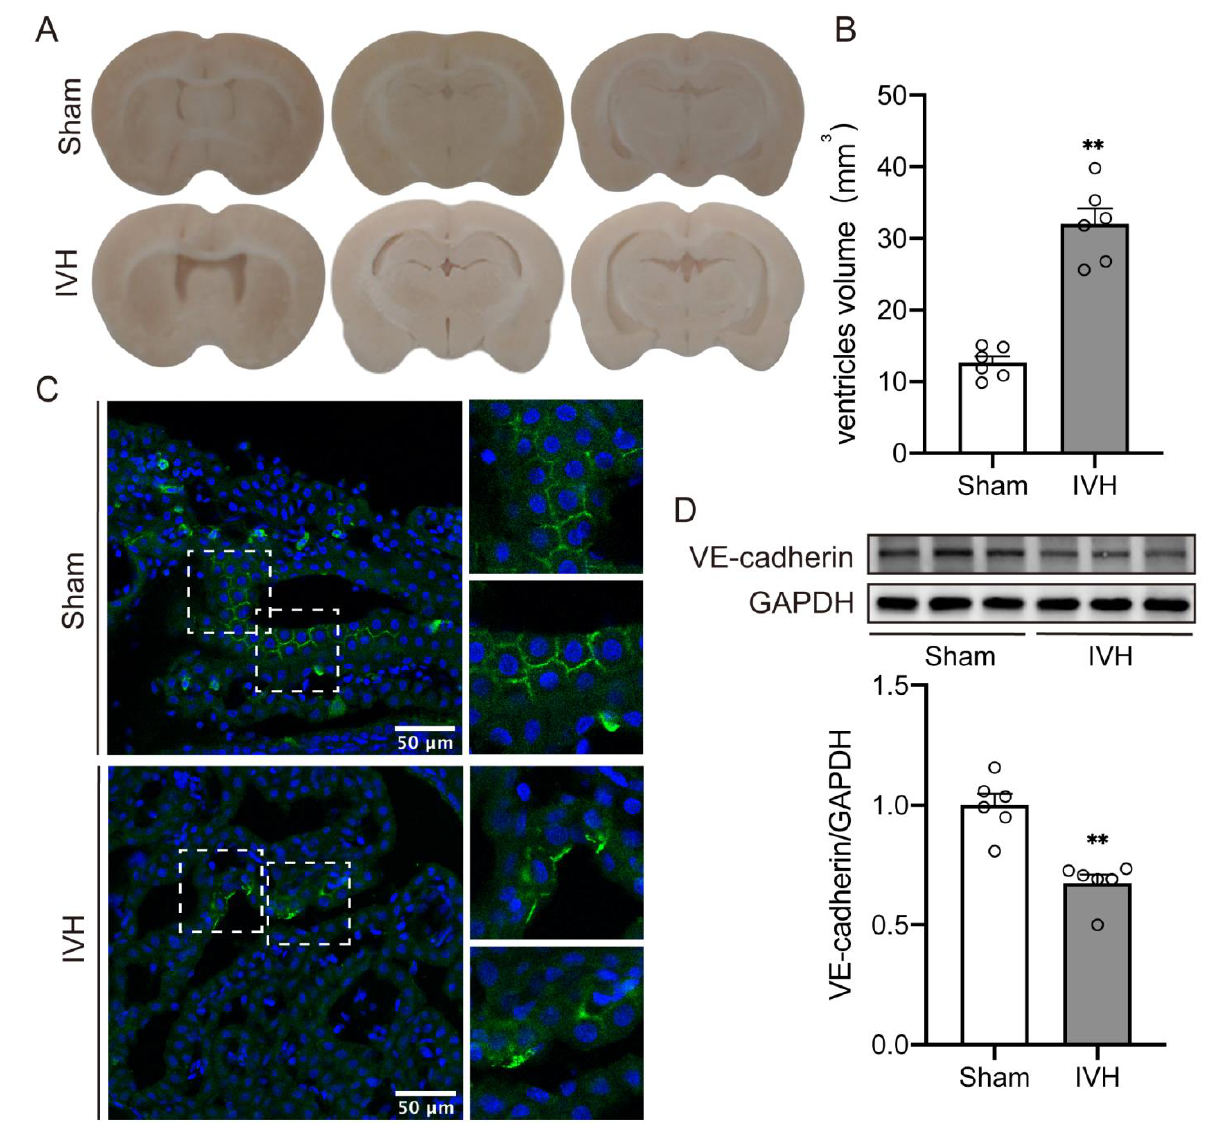
Figure 1. Ventricular injection of homologous blood caused hydrocephalus and downregualtion of choroid plexus VE – cadherin expression ( A ) Frozen coronal brain sections at 7 days after injection of 200 μL of saline or blood into the right lateral ventricle. ( B ) Quantification of lateral ventricle volume from section images, n = 6. ( C ) Immunofluorescence staining of coronal sections showed the expression of VE – cadherin in choroid plexus, n = 4, Scale bar = 50 μ m. ( D ) VE – cadherin expression level was assessed by western blot, n = 6. Data were analyzed by t-test for comparisons between two groups. Values are means ± SEM, ** p < 0.01.